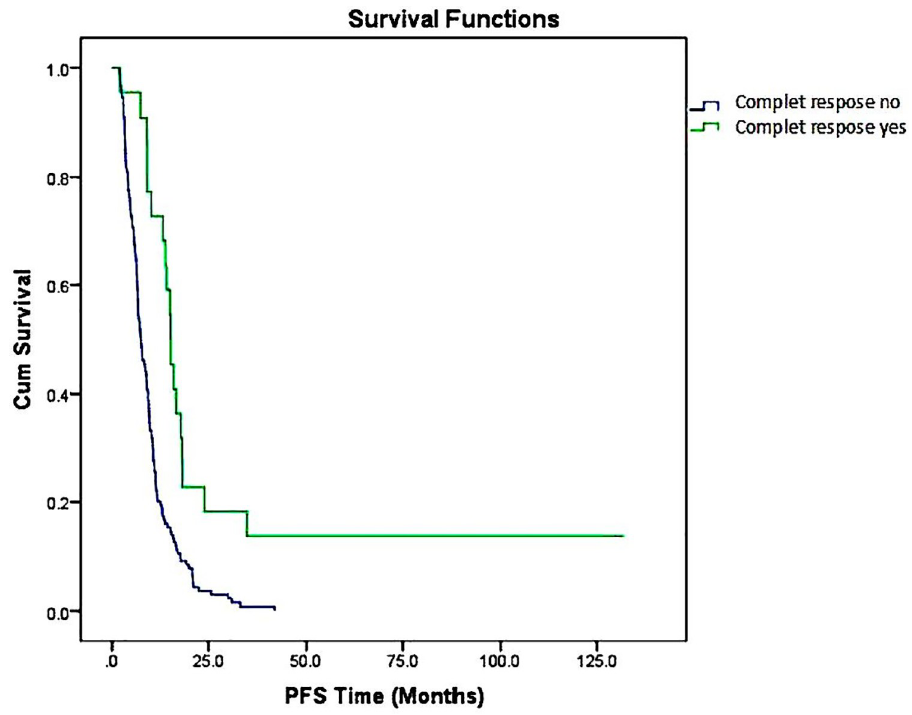
Fig 2. Progression-free survival analysis based on whether a complete response was